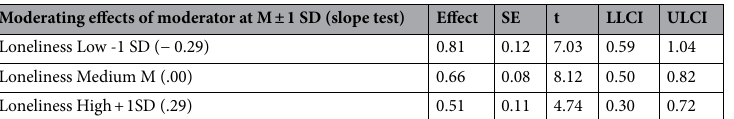
Moderating effects of moderator at M ± 1 SD (slope